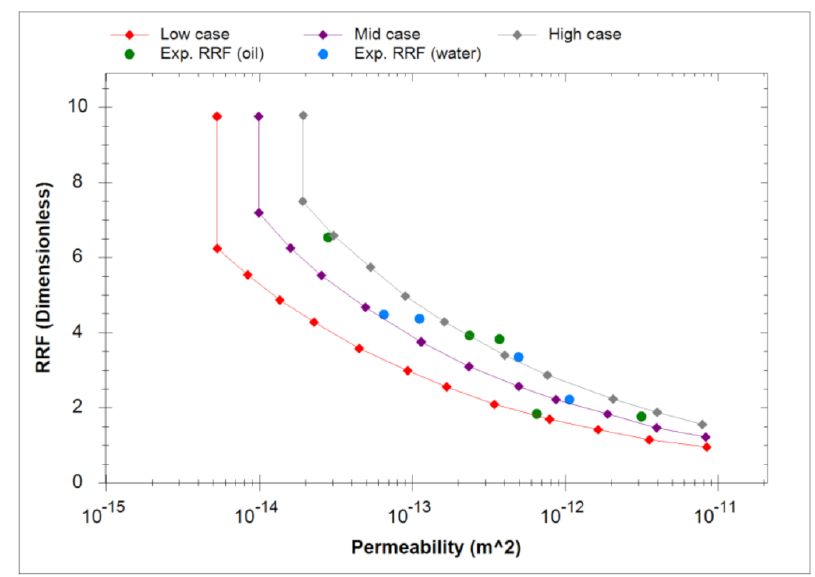
Figure 2. Proposed low, mid, and high RRF correlations based on lab data (Modified from